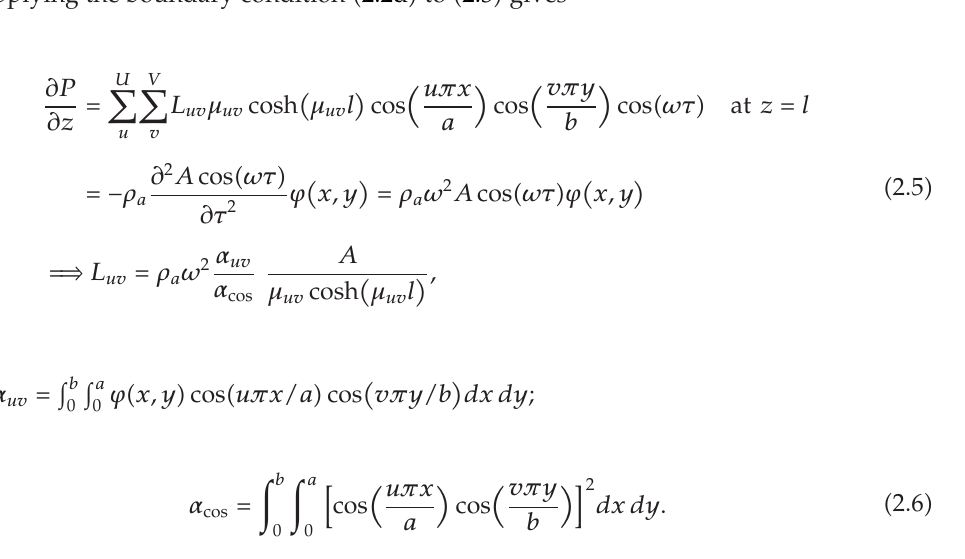
(cid:7) 0 . (cid:3) 2.4 N uv